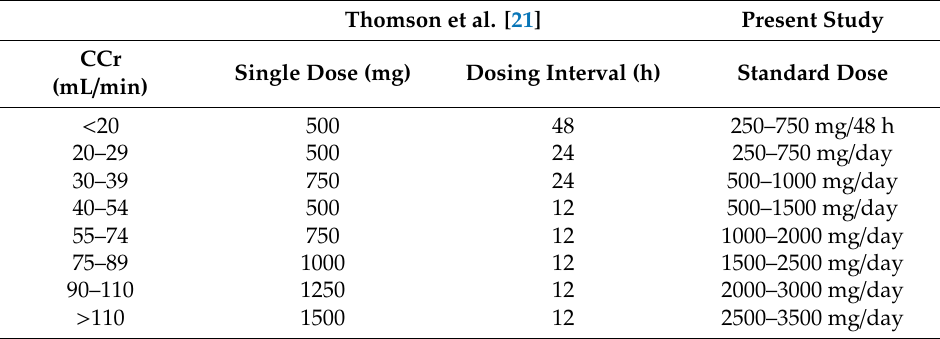
Table 3. Comparison of standard